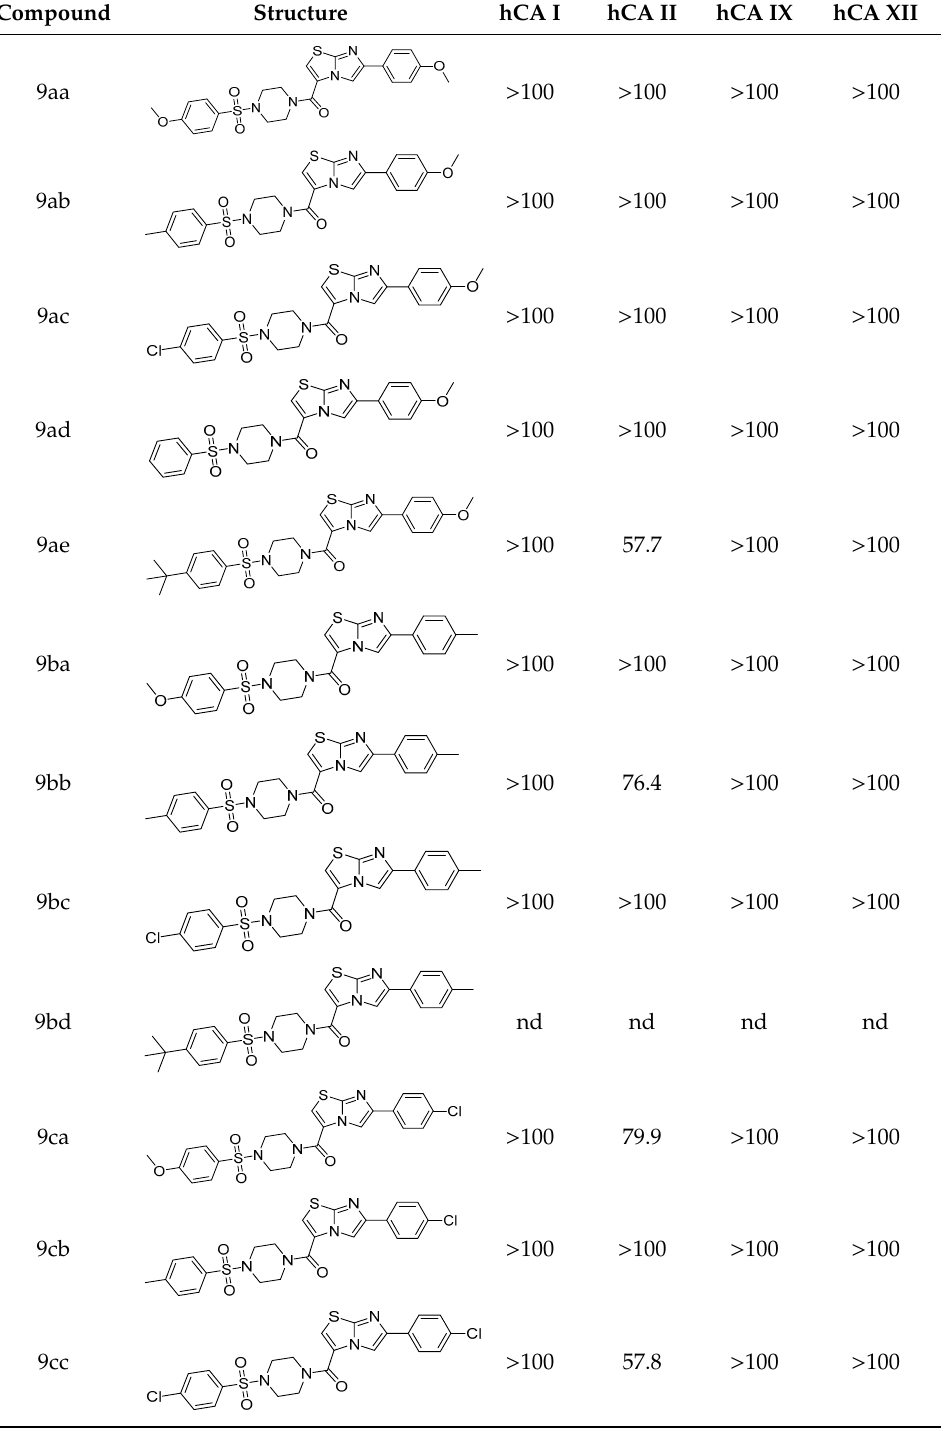
Table 1. Inhibition of hCA isoforms I, II, IX and XII with target compounds (9aa-ee) and acetazolamide (AAZ) as a standard drug (K i -µM) a . Compound Structure Compound